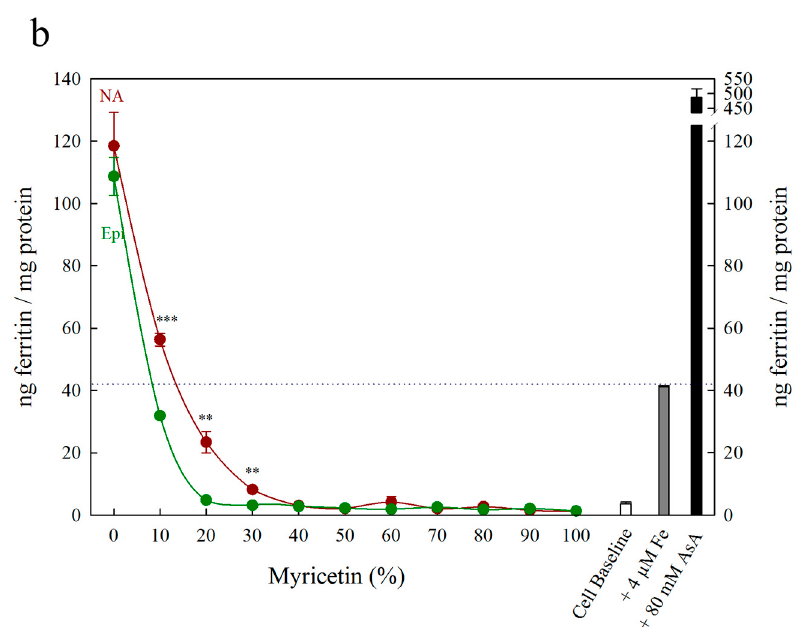
Figure5. FerritinformationinCaco-2cellsinresponsetovariousmolarratiosofnicotianamine:myricetin Figure 5. Ferritin formation in Caco-2 cells in response to various molar ratios of (NA, red) and epicatechin:myricetin (Epi, green). Total metabolite concentration at each data point was nicotianamine:myricetin (NA, red) and epicatechin:myricetin (Epi, green). Total metabolite ( a ) 4 µ M and ( b ) 30 µ M. Dotted line indicates ferritin response to 4 µ M Fe alone and is extended to both concentration at each data point was ( a ) 4 μ M and ( b ) 30 μ M. Dotted line indicates ferritin response y axes to facilitate comparison with other treatments. Error bars represent standard error of the mean to 4 μ M Fe alone and is extended to both y axes to facilitate comparison with other treatments. Error of three replicates. Asterisks denote the significance between NA and Epi at each molar ratio for p < bars represent standard error of the mean of three replicates. Asterisks denote the significance 0.05 (*), p ≤ 0.01 (**), p ≤ 0.001 (***) as determined by Student’s t between NA and Epi at each molar ratio for p < 0.05 (*), p ≤ 0.01 (**), p ≤ 0.001 (***) as determined by Student’s t -test.